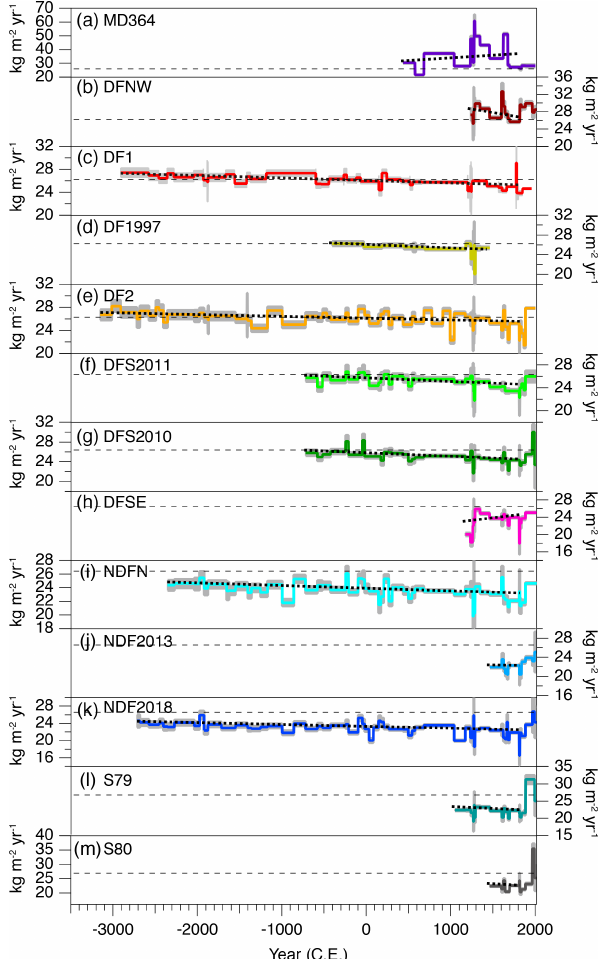
Figure 6. Accumulation rates around Dome Fuji and other high- elevation sites in Dronning Maud Land reconstructed from shallow ice cores and snow pits. The horizontal dashed black line in each panel indicates the average value at the Dome Fuji station over the last 5kyr (26.2kgm − 2 yr − 1 ). Grey shading indicates the estimated uncertainty (2 σ ). The dotted line indicates a statistically significant long-term trend from the bottom year to 1850CE (to 1461CE for the DF1997). Slope values are summarized in Table